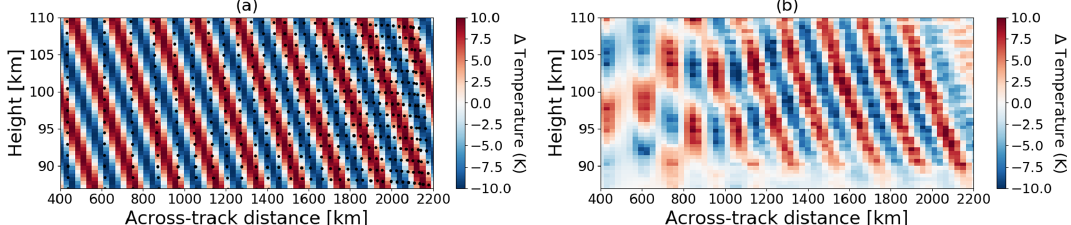
Figure 12. Simulated GW (a) with a vertical wavelength of 10km and horizontal wavelength of 250km, and retrieved wave structure (b) assuming a turning angle α of 90 ◦ . The tangent points from individual measurements are marked as white circles in (a) .